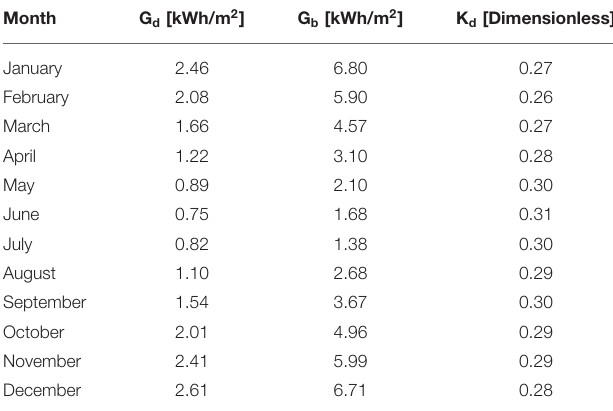
TABLE 2 | Monthly setting values for diffuse proportion